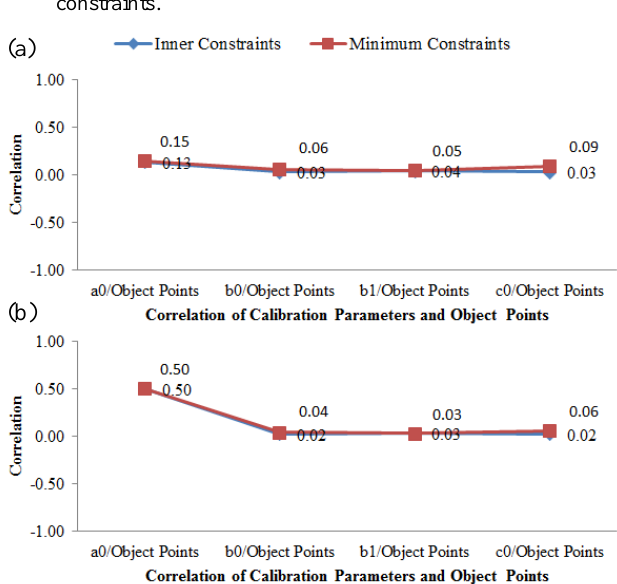
Figure 10. Parameter correlations of calibration parameters and object points (full network configuration), (a) Faro Photon 120 and (b) Faro Focus 3D.